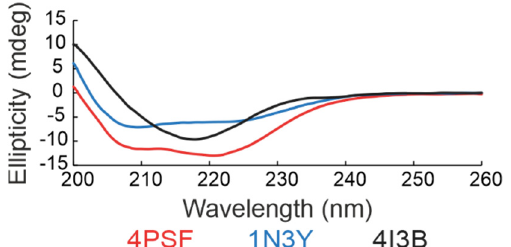
Figure 3. Far-ultraviolet (UV) circular dichroism (CD) spectra of three scaffold candidates. The results indicate that all three proteins acquire the expected secondary structure features. The 4PSF (red) and 1N3Y (blue) showed a combination of alpha-helices and beta-sheets, whereas the 4I3B (black) formed mainly beta-sheets.